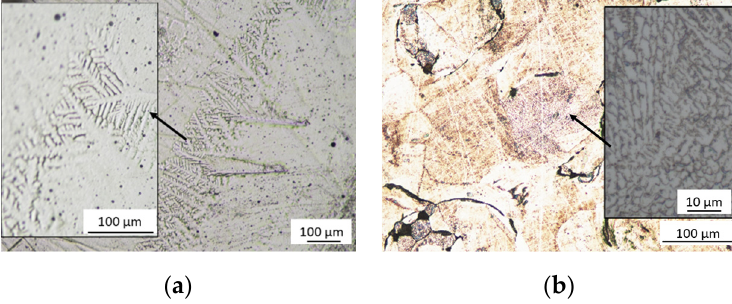
Figure 4. Optical microscope pictures obtained for tested sample: ( a ) cast sample; ( b ) SLM sample.